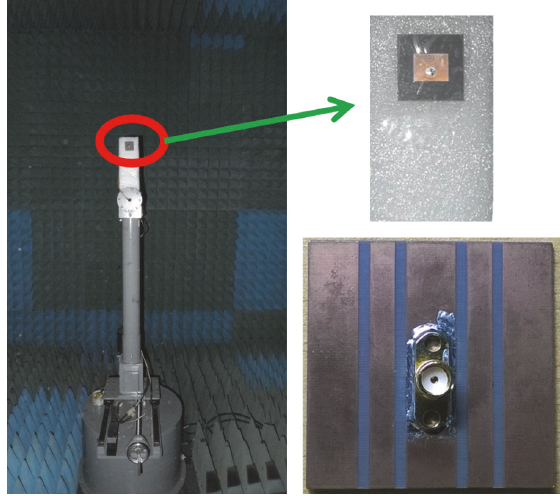
Figure 2: One measured prototype in the anechoic chamber.